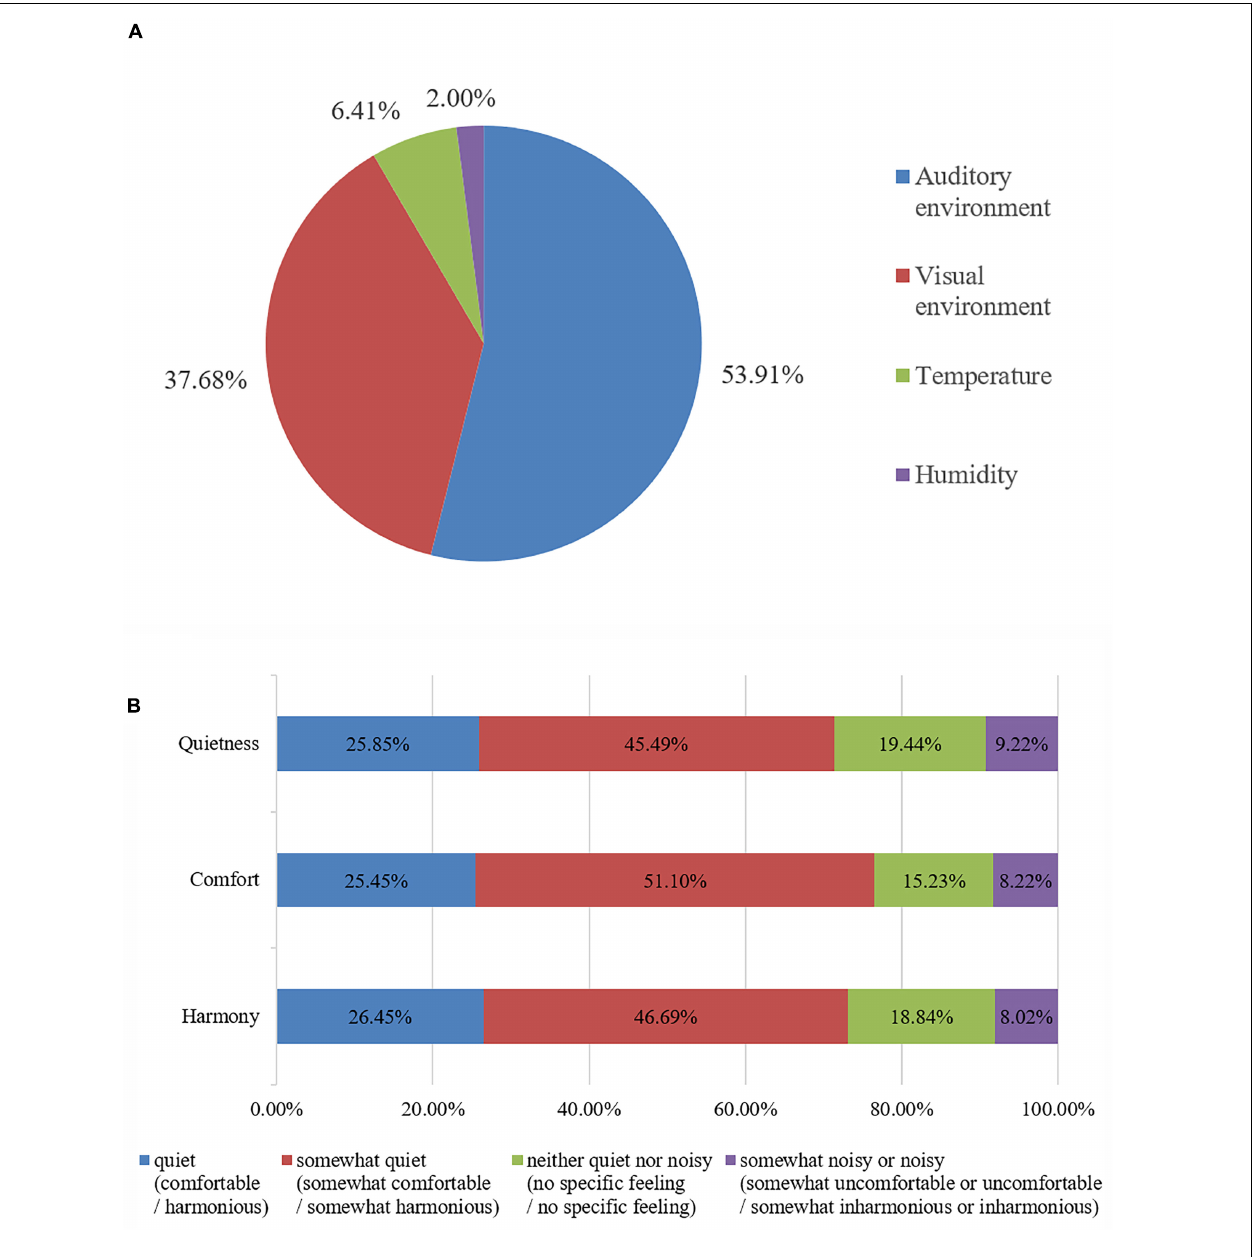
FIGURE 1 | Distribution of the respondents’ environmental evaluations of the temple. (A) The first influencing factor; (B) Evaluation of the acoustic environment.